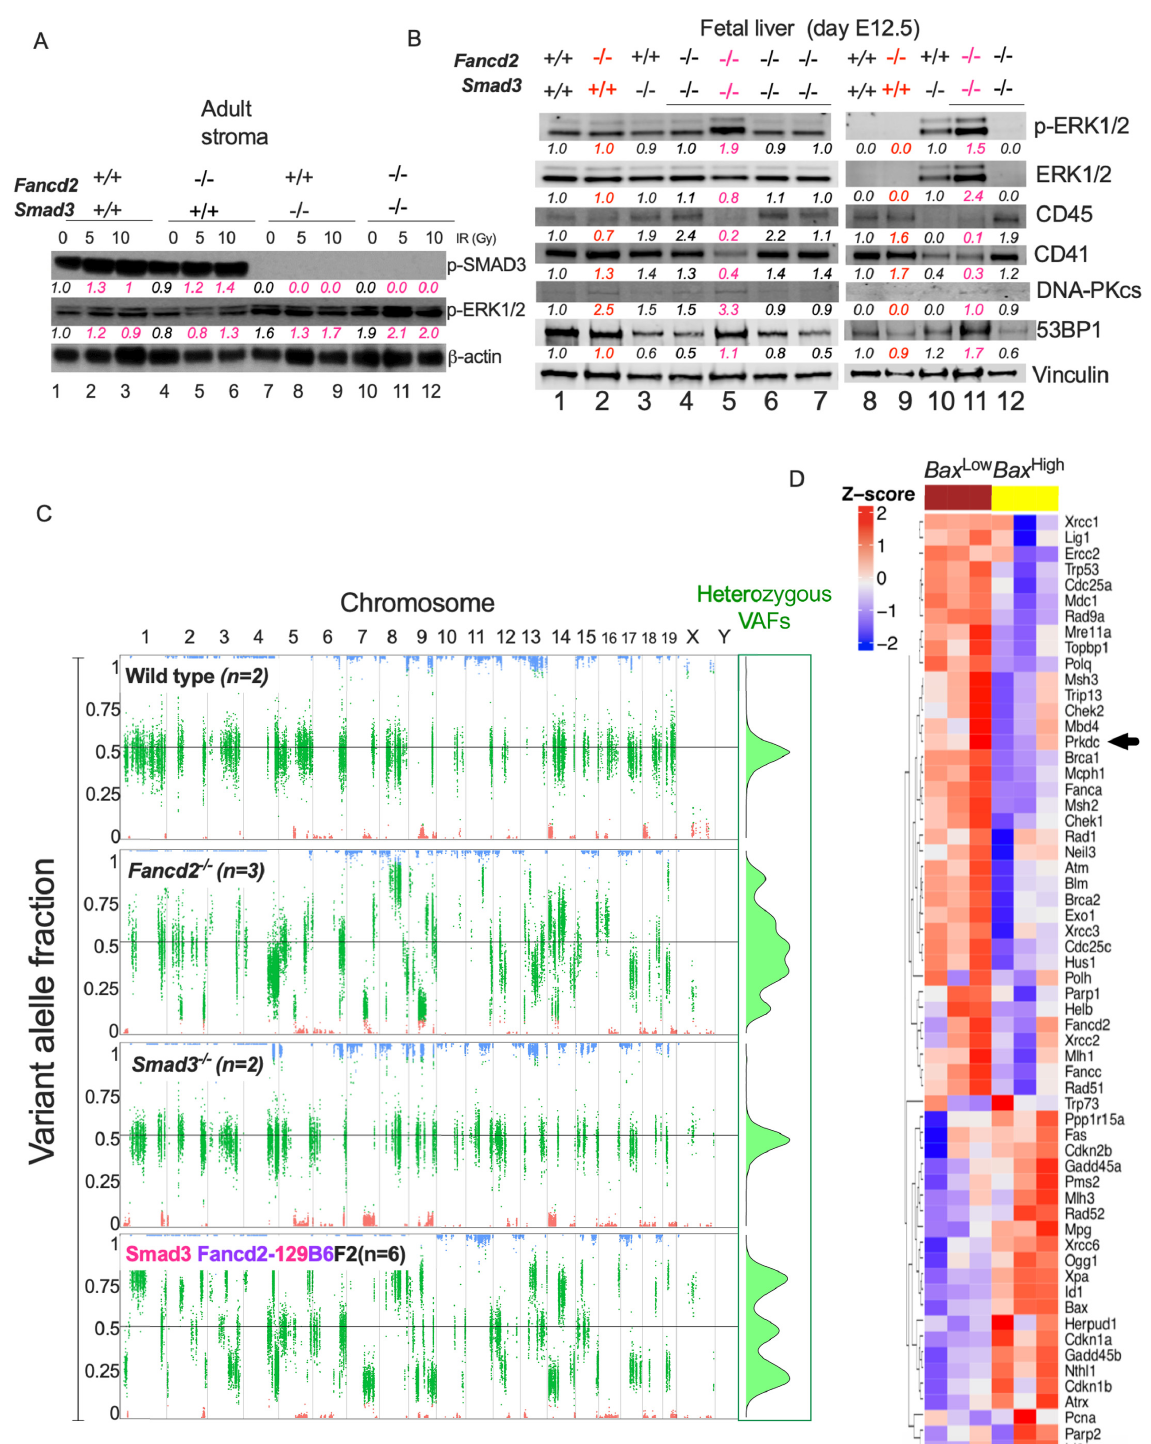
Fig 4. Smad3 Fancd2-129B6F2 embryos with ERK pathway activity express NHEJ components. (A) Western blot of the lysates from adult bone marrow stroma cells of mice showing that irradiation activates the canonical phosphorylation of Smad3 in bone marrow stroma of WT and Fancd2 -/- mice and activates the non-canonical ERK1/2 phosphorylation in Smad3 -/- and DKO mice stroma. Quantifications relative to wild type in basal conditions and the loading control are shown below every lane. Pink indicates the irradiated cultures per cell line. (B) Western blot of the lysates from E12.5 fetal liver showing that a subset of Smad3 Fancd2-129B6F2 embryos have higher levels of the